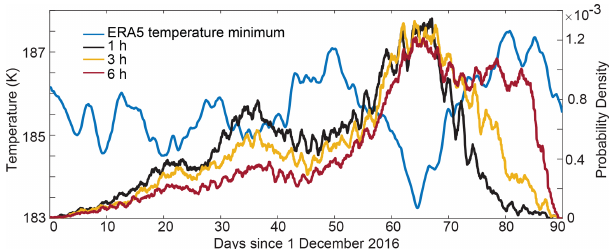
Figure 3. The daily running mean zonal minimum temperature av- eraged between 15 ◦ S and 15 ◦ N and 79 to 103hPa for DJF 2017 from ERA5 data (blue), and the daily running mean PDFs of the time at which the cold point is observed by 1 (black), 3 (orange), and 6h (red) trajectories. Trajectories are run in reverse from the end of this timeframe, so the distribution shifts to the left with in- creased transit